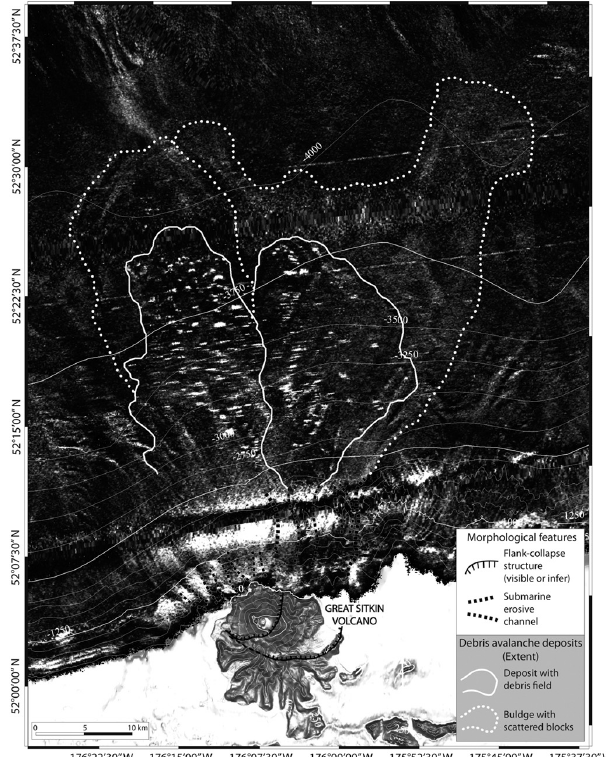
Fig. 10. Topography, bathymetry and Gloria side-scan data of Great Sitkin Volcano and its north submarine flank. The image displays the two inferred deposits characterized by the alignment of the largest blocks of the DA (as reported in the text). For side scan data the black is low backscatter and white is high backscatter. Contour interval is 250m.